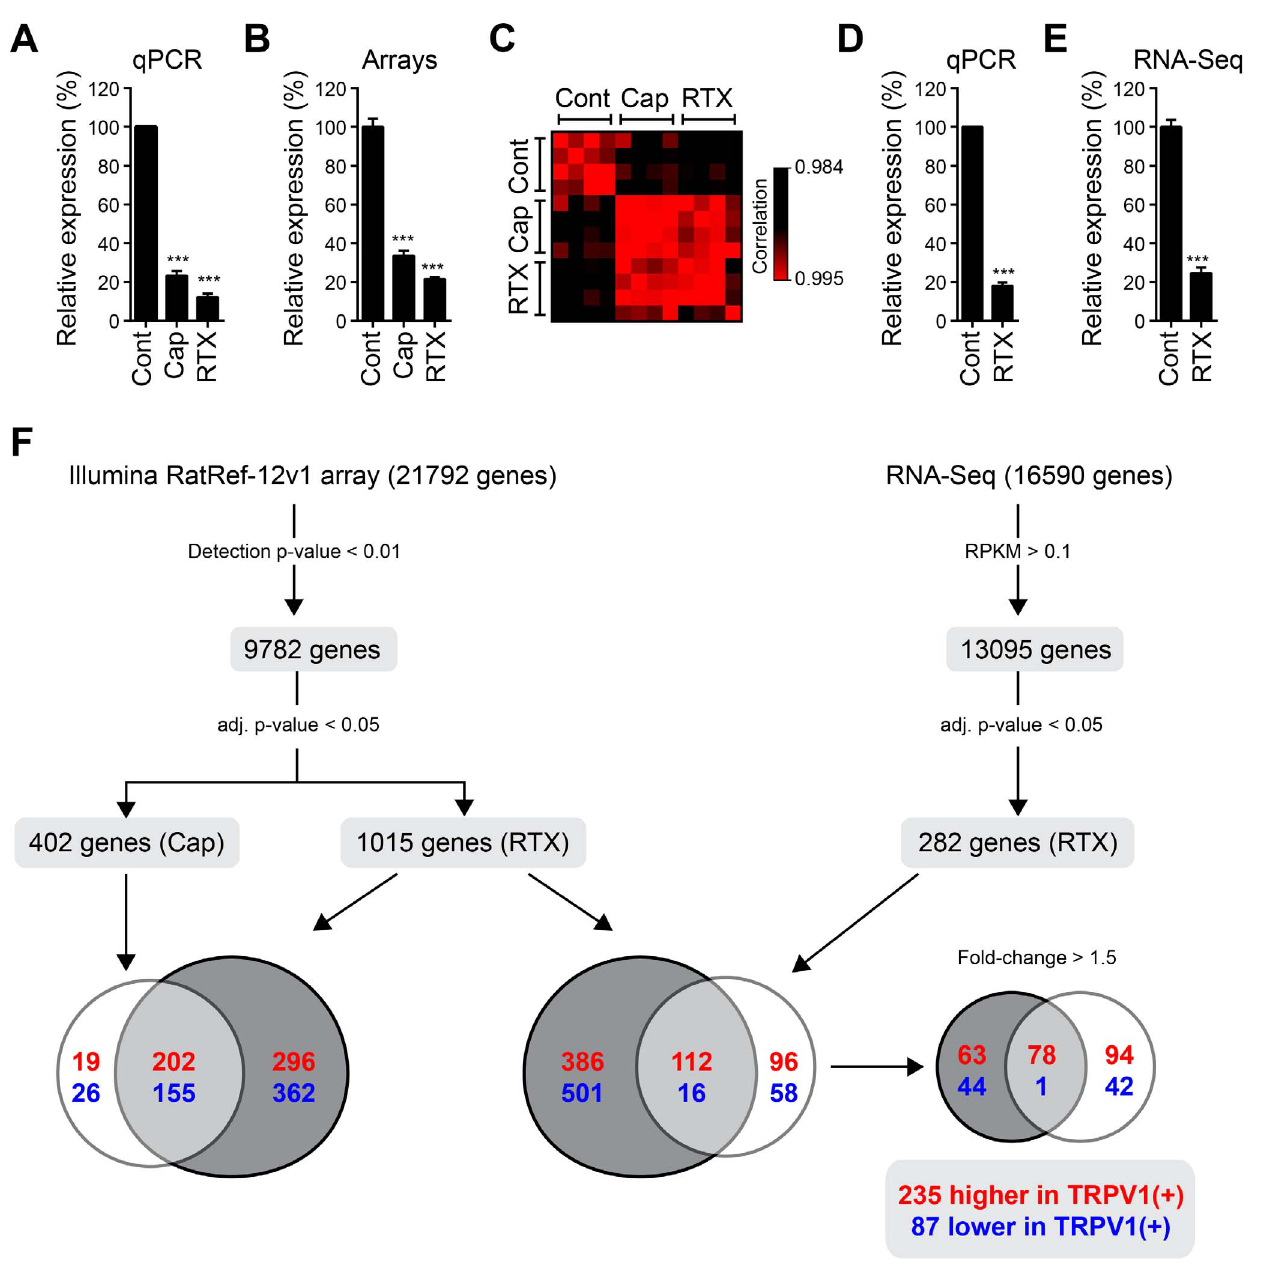
Fig. 2. Transcriptome analysis reveals novel pain targets enriched in TRPV1( + ) neurons. (A) qPCR quantification of TRPV1 mRNA levels in samples hybridized on microarrays (n 5 4, p , 0.001, One-way ANOVA). (B) Relative expression levels of TRPV1 mRNA determined by microarray hybridizations (n 5 4, p , 0.001, One-way ANOVA with Bonferroni’s multiple comparisons test). (C) Correlation matrix of the expression level of all genes (normalized fluorescence intensities) detected using micorarrays. Clustering of overall gene expression is visible between RTX and capsaicin treated samples. (D) qPCR quantification of TRPV1 mRNA levels in samples used for RNA-Seq (n 5 3, p , 0.001, paired two-tailed t-test). (E) Relative expression levels of TRPV1 mRNA determined by RNA- Seq (n 5 3, p , 0.001, One-way ANOVA). (F) Overview of the number of target transcripts identified by microarray hybridizations and RNA-Seq. Raw fluorescence intensities of microarrays were background corrected, log2 transformed, normalized, and filtered for expressed genes (Illumina detection p-value , 0.01 in at least oneof the samples, seeMaterialand Methodssections for details). Sequencing was performedusing a 5500xl SOLiDSystem resulting in 664 million readsin total (seeMaterialand Methods sectionsfor details). Thereads were filtered to remove ribosomal RNA, tRNAs, and vectorsequences. The remaining readsmapped to 16590 genes of the reference genome (rn5). Read counts were transformed to RPKM values (Reads per kilo base per million), normalized, and filtered to remove weakly expressed transcripts (RPKM . 0.1). P-values of differentially expressed genes identified with both methods were adjusted for multiple testing with Benjamini and Hochberg’s method, adjusted p-values , 0.05 were considered significant.